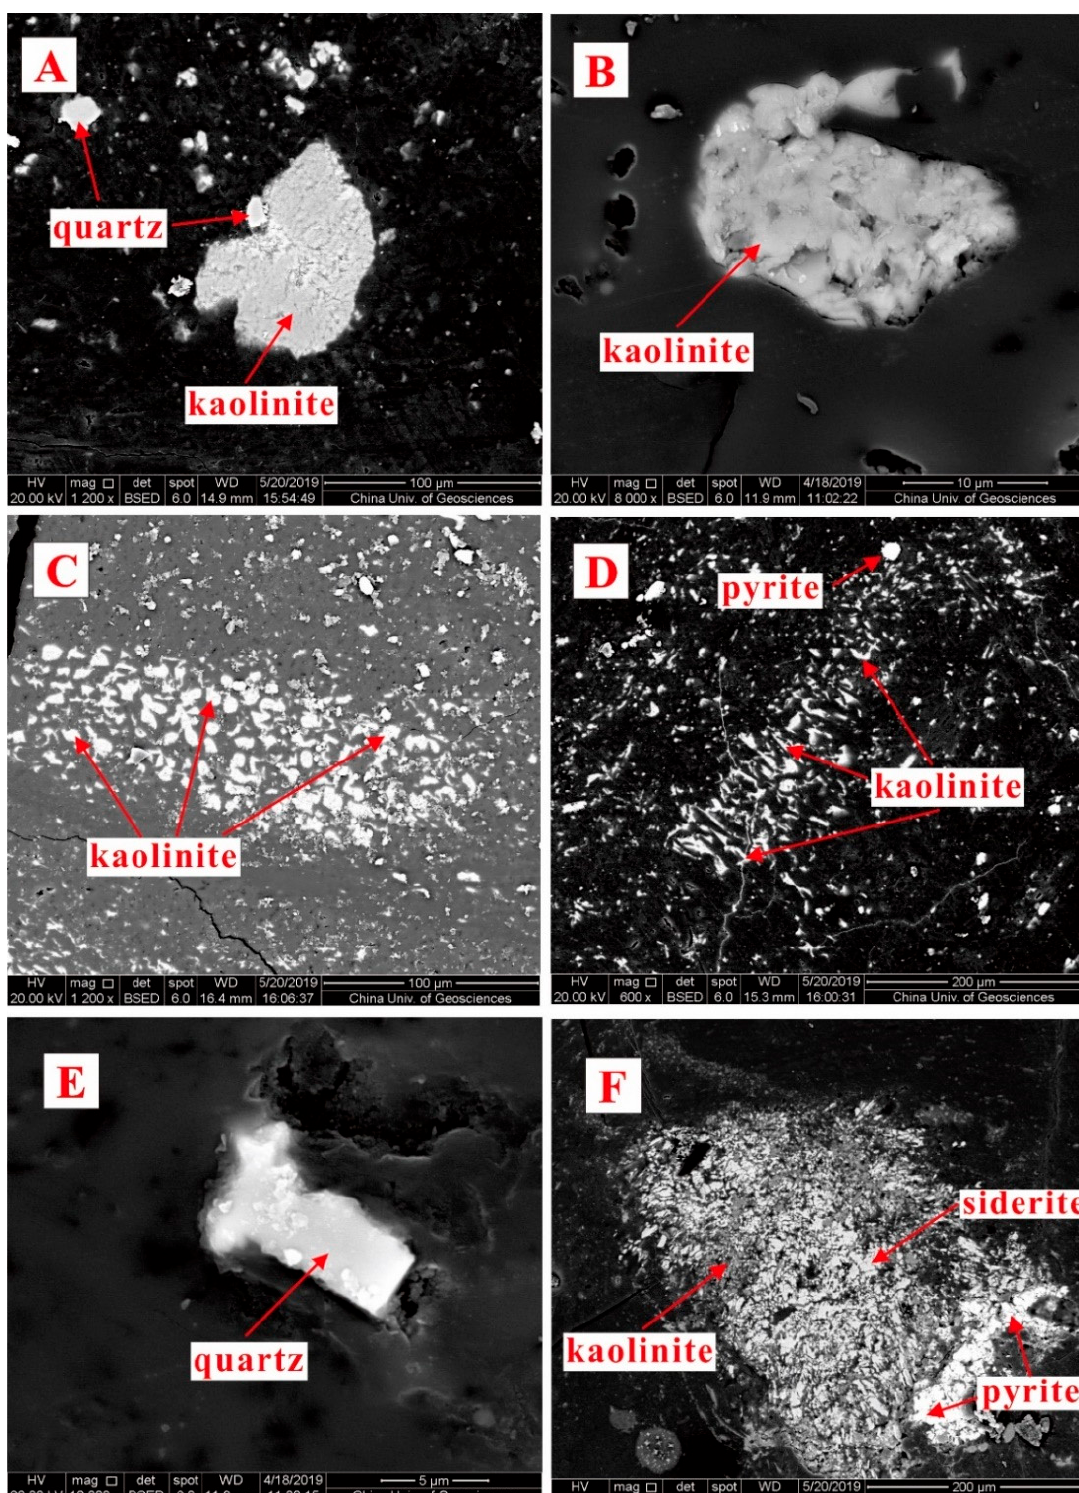
Figure 3. SEM back-scattered images of kaolinite, quartz, pyrite and siderite in the sample of CJG-1-1. ( A ) dispersed kaolinite and quartz particles; ( B , C ) syngenetic cell-filling kaolinite; ( D ) syngenetic cell-filling kaolinite and detrital pyrite grain; ( E ) authigenic quartz; ( F ) mineral assemblage including siderite, kaolinite, and framboidal pyrite.